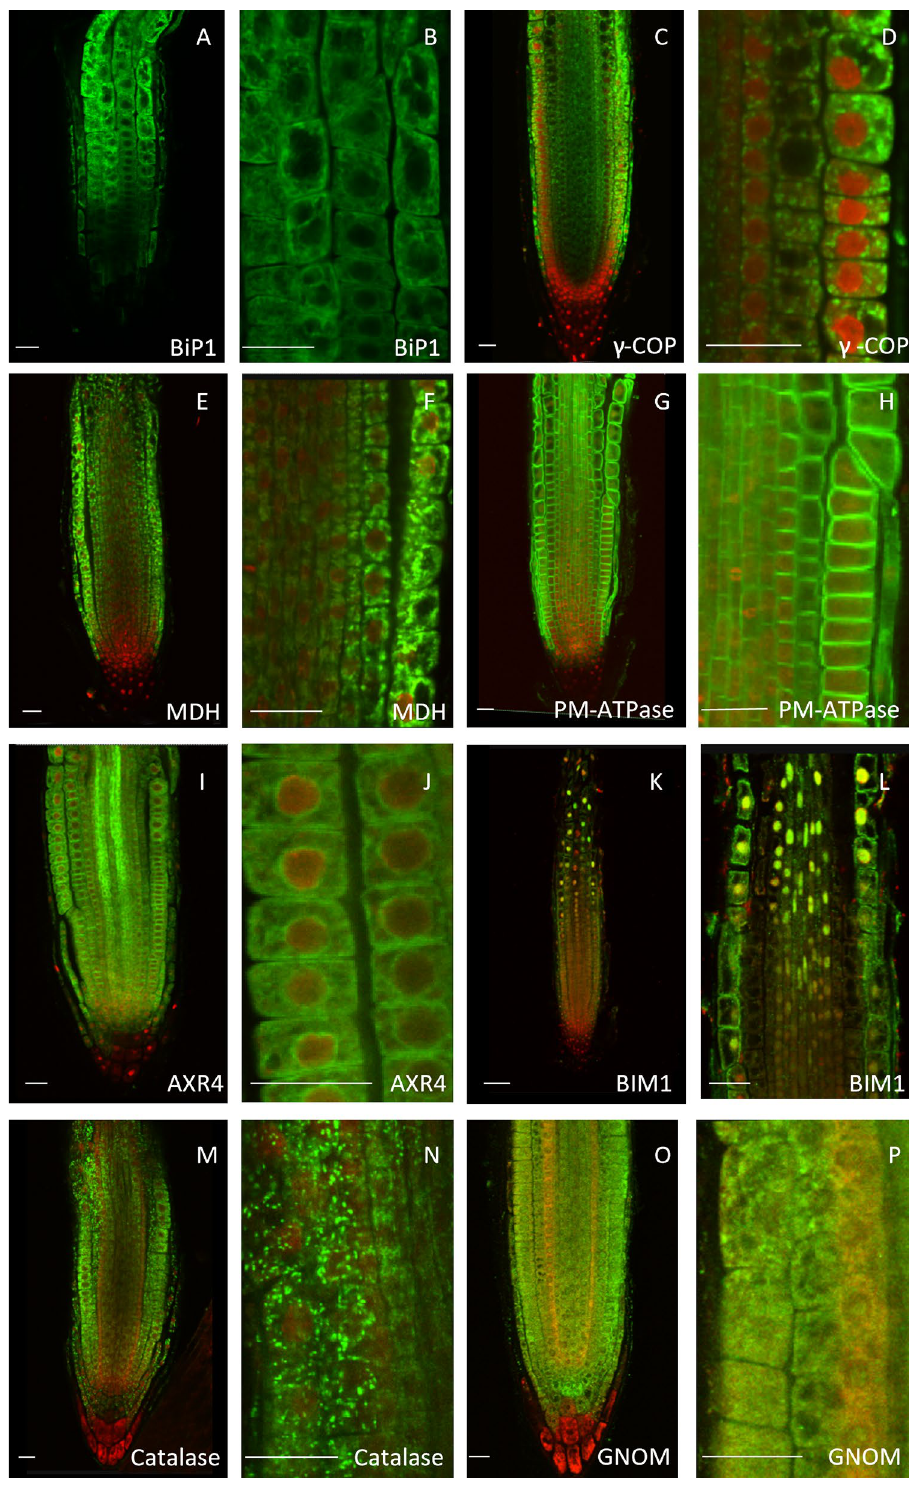
Figure 7. CPIB antibody project has raised antibodies against several popular sub-cellular markers: BiP (ER), γ-cop (golgi), PM-ATPase (PM) and malate dehydrogenase (plastid). Antibodies were raised against popular sub cellular marker proteins ( A – H ) and other root proteins (AXR4 (ER), BIM1 (nucleus), catalase (peroxisome) and GNOM (endosome) that potentially can be used as subcellular markers ( I – P ). The antibodies were used for immunodetection of the targets (green) in 4-day old wild type Columbia roots. Primary and Alexafluor 488 coupled secondary antibodies were used at 1:200 dilutions. Seedlings were counter stained using propidium iodide (red). Scale bar 20